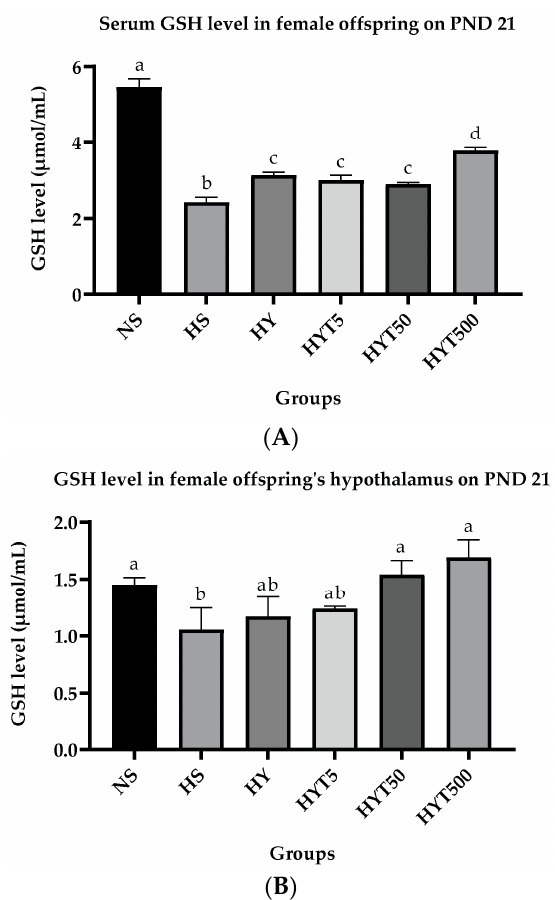
Figure 9. ( A ). Serum GSH level in female offspring on PND 21. ( B ). GSH level in hypothalamus of female offspring on PND 21. NS: normal chow and saline; HS: HFD and saline; HY: HFD and yo- ghurt; HYT5: HFD and 5 mg/kg of E. tapos yoghurt; HYT50: HFD and 50 mg/kg of E. tapos yo- ghurt; HYT500: HFD and 500 mg/kg of E. tapos yoghurt. Values are expressed as mean ± SEM. Dif- ferent letters indicate a significant difference at p <